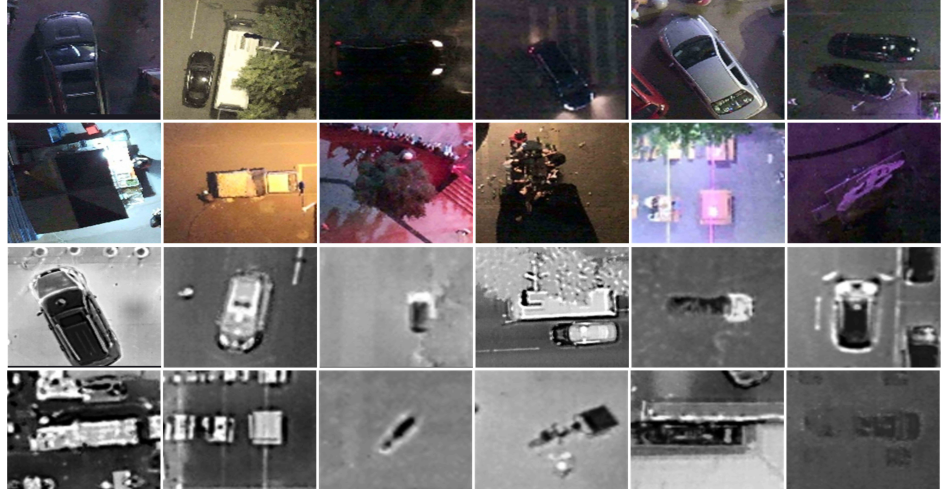
Figure 2. Some examples of paired vehicles and interferences. The first row is the vehicle in the visible image, the second row is the interference in the visible image, the third row is the vehicle in the infrared image and the fourth row is the interference in the infrared